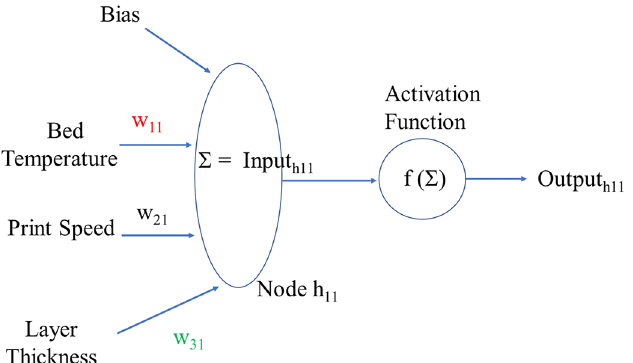
Fig. 5. ANN structure.